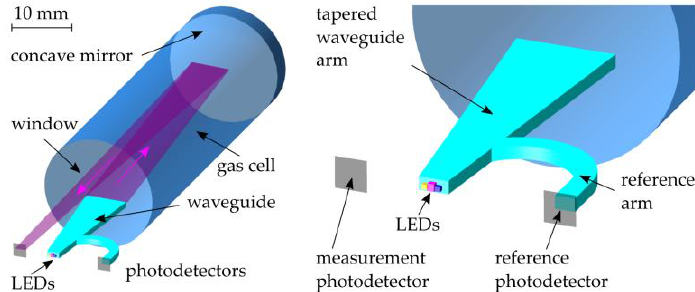
Figure 1. Schematics of the DUV-LED based gas sensor utilizing a tapered waveguide: the light is splitted into a main path and a reference path. The tapering improves the efficiency by light collimation. The absorption length is doubled by use of a concave mirror at the back face of the gas